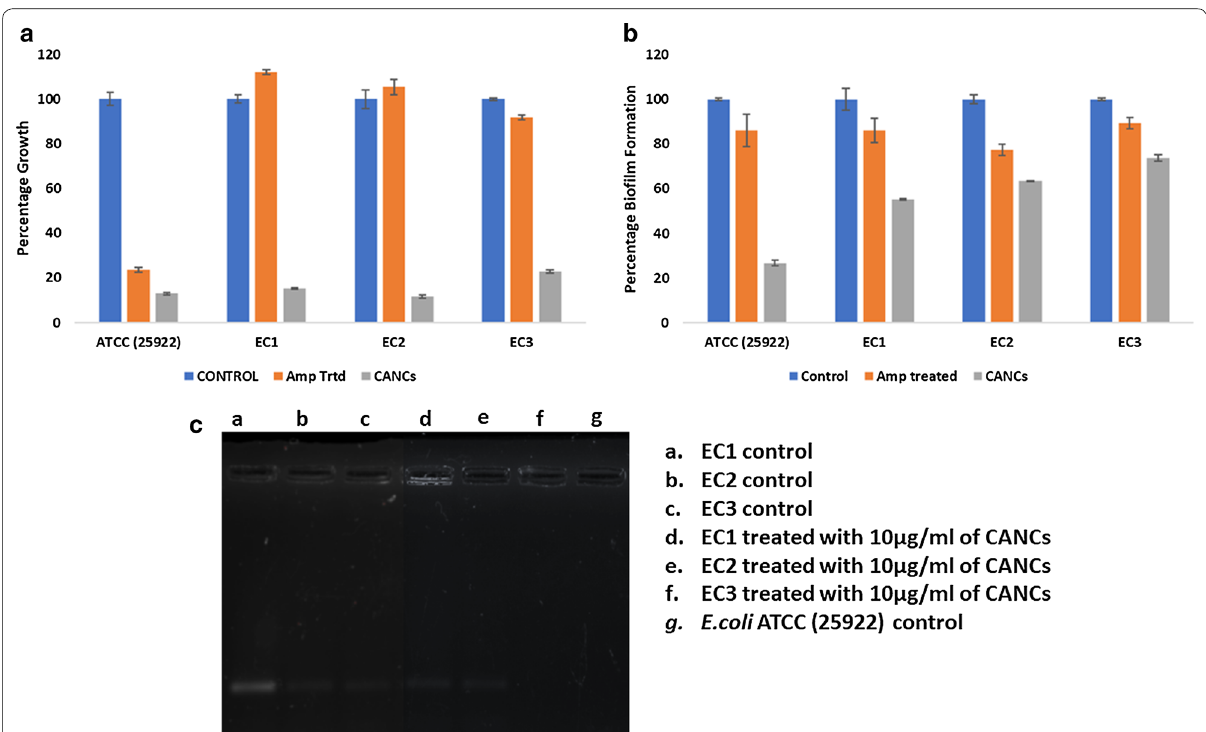
Fig. 5 a Analysis of growth percentage in control and treated with antibiotic and CANCs in ATCC (25922) and clinical strains of E. coli . b Analysis of biofilm formation in control, treated with antibiotics and CANCs in ATCC (25922) and clinical strains of E. coli. c Analysis of expression of CTX-M-15 gene in control and treated with CANCs; ( a EC1, b EC2, c EC3 control) ( d EC1, e EC2, f EC3 treated with CANCs), g ATCC (25922)